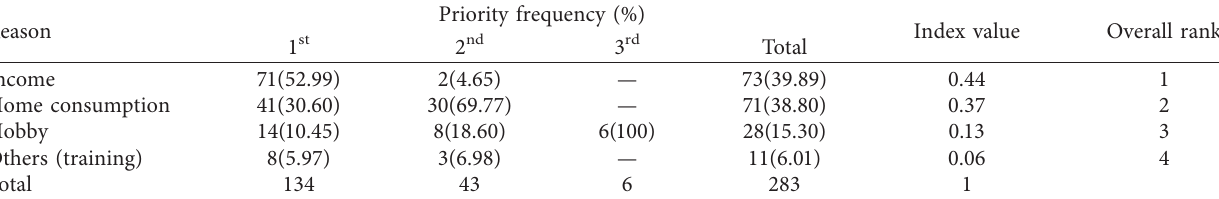
Table 5: Rank index for reasons of engaging in beekeeping.